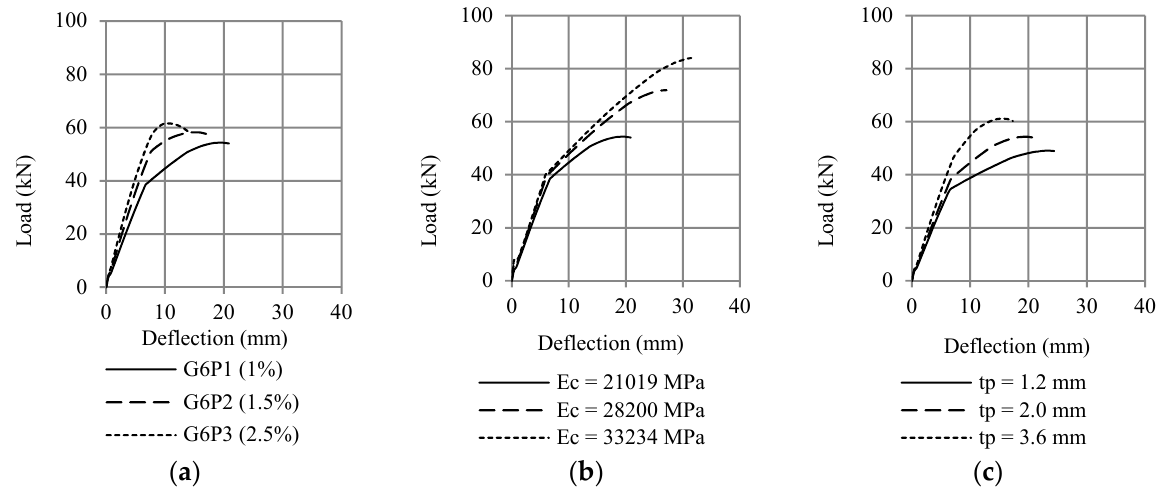
Figure 13. Effect of ( a ) ratio of tensile reinforcement, ( b ) the elastic modulus of the concrete, and ( c ) plate thickness on the flexural capacity using RCCSA.